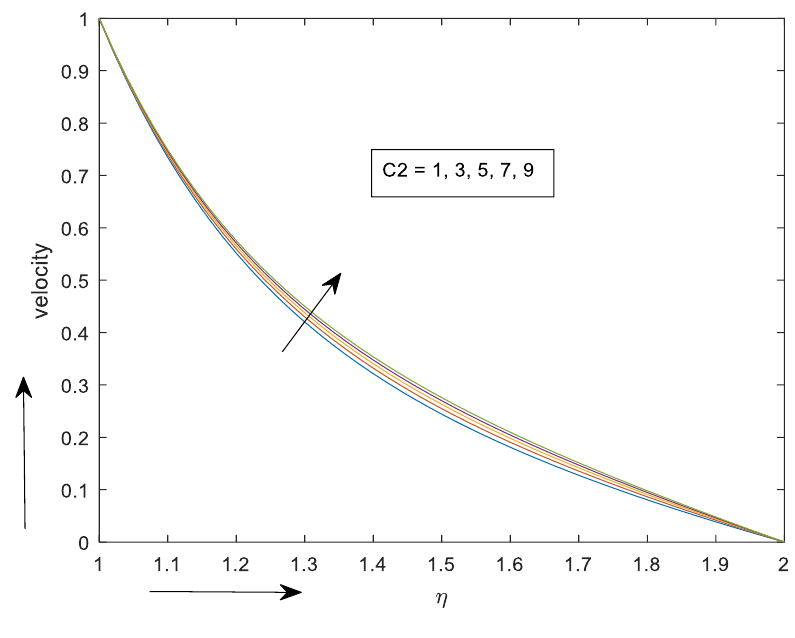
Figure 2. Velocity profile for different values of 𝐶